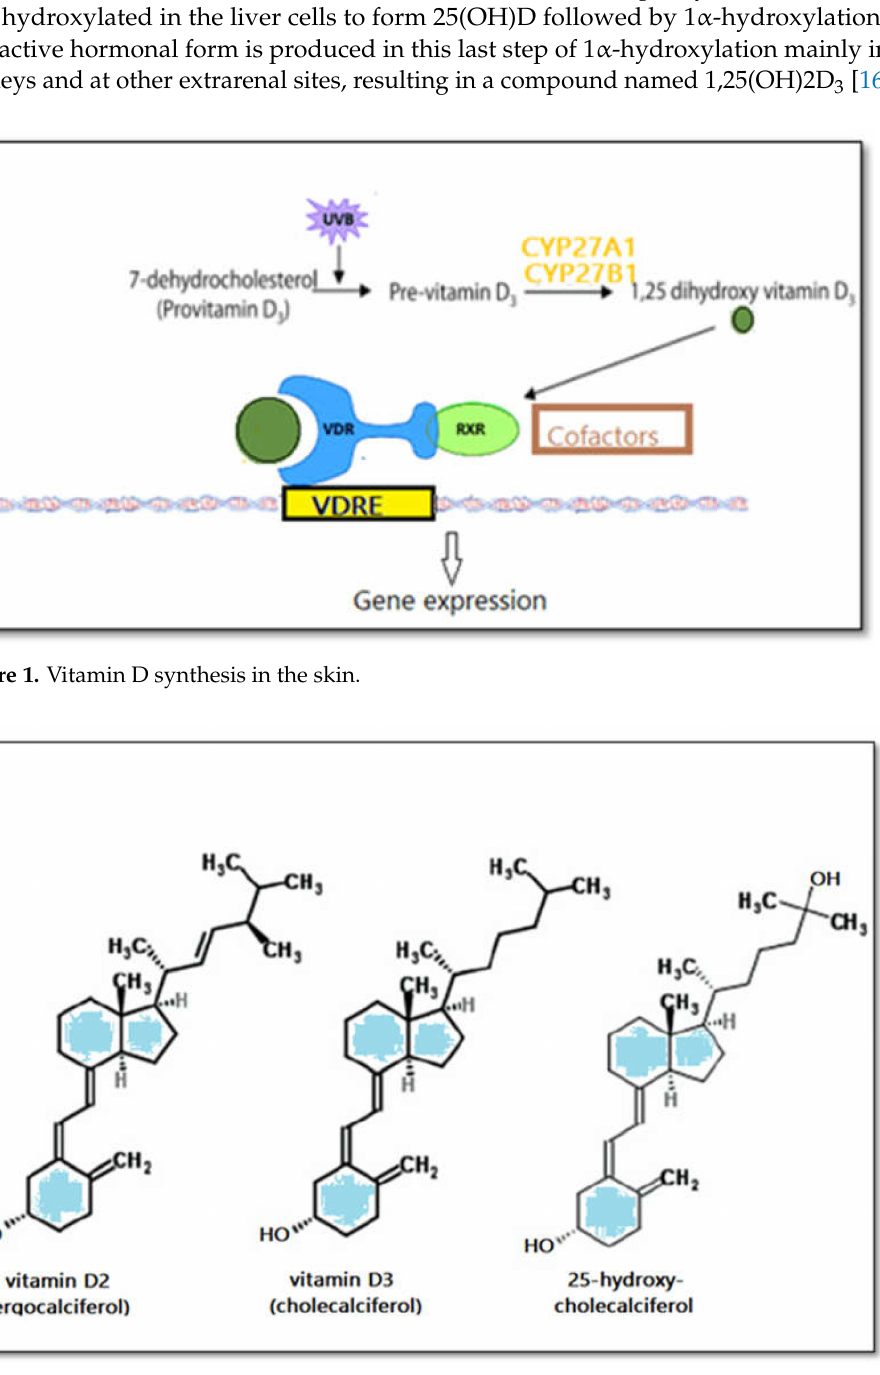
Figure 2. Structure of vitamin D and its